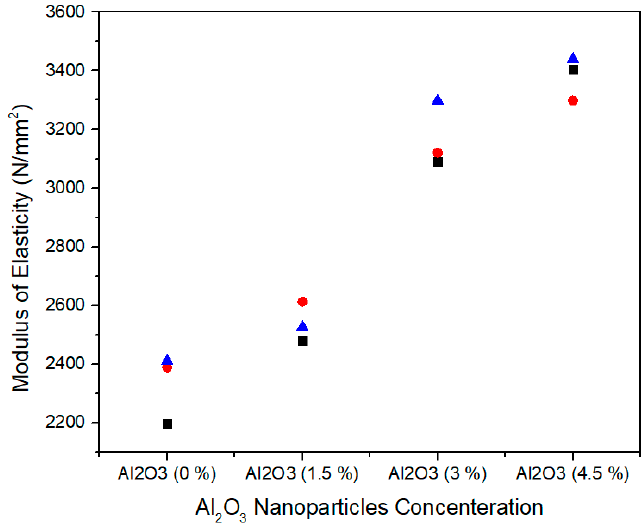
Figure 13. Numerical values of modulus of elasticity (MOE) of various treatments of alumina nanoparticles.